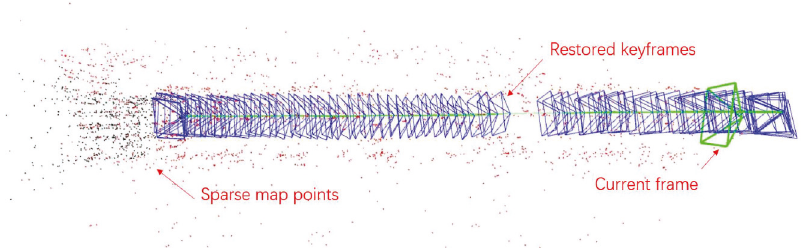
Figure 5: Image map with map points and keyframes.